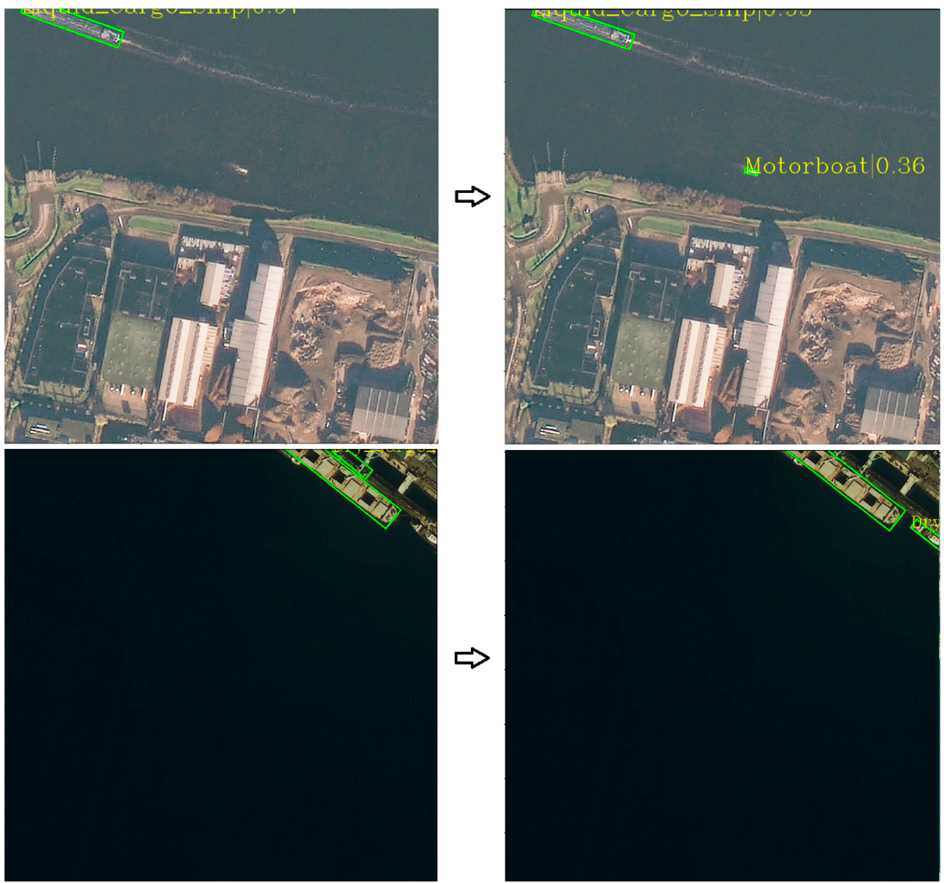
Figure 15. Model detection effect before and after replacing with NAS FPN.